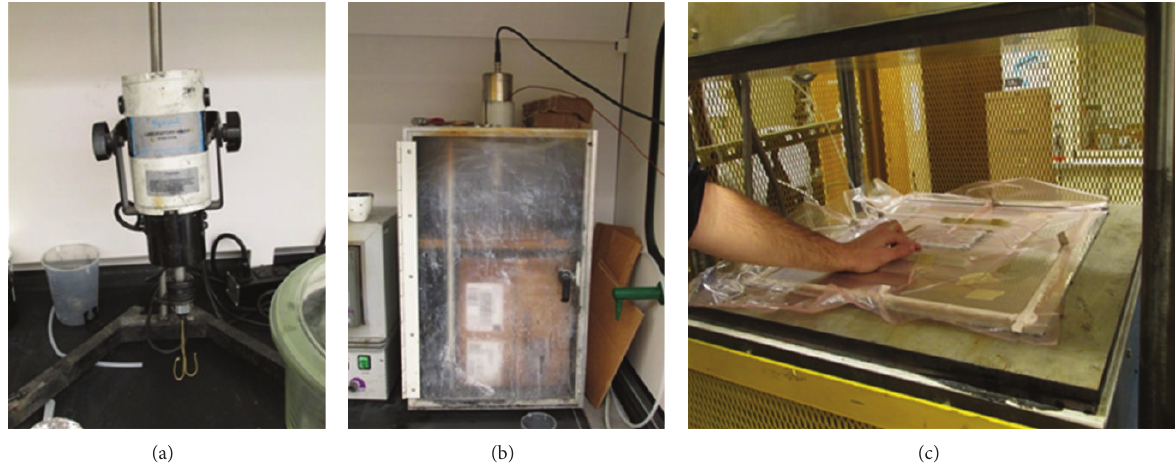
Figure 1: Mechanical mixer and sonicator ((a) and (b), resp.) used during resin and nanoresin preperation and vacuum bag system in open hotpress (c) for OOA-VBO